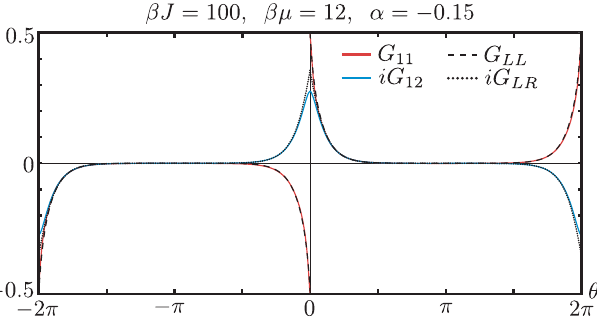
FIG. 14. Plot of solutions G Ref. [44] superimposed with G 11 and iG 12 . Parameters chosen so that the solutions are close for most of the range of θ .